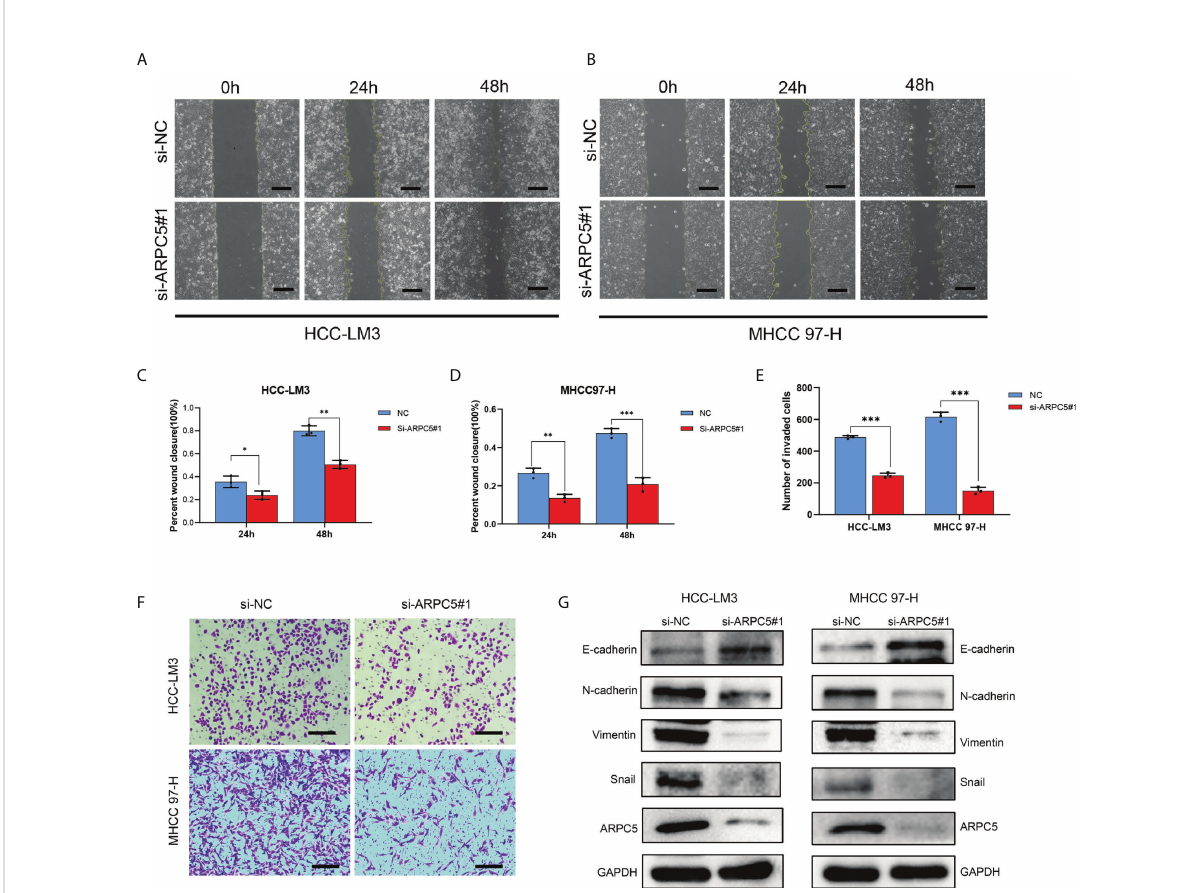
FIGURE 12 Role of ARPC5 inhibition on migration, invasion, and epithelial – mesenchymal transition (EMT) of HCC cells. (A – D) Migration ability was assessed by scratch wound healing assay, representative images (A, B) were shown (original magni fi cation, ×200; scale bars, 50 µm), and wound healing areas were calculated (C, D) . (E , F) Transwell assay was applied to examine the invasion ability, representative images (F) were shown (original magni fi cation, ×200; scale bars, 50 µm), and the histogram showed the number of invasion cells (E) . (G) Western blot showed the changes